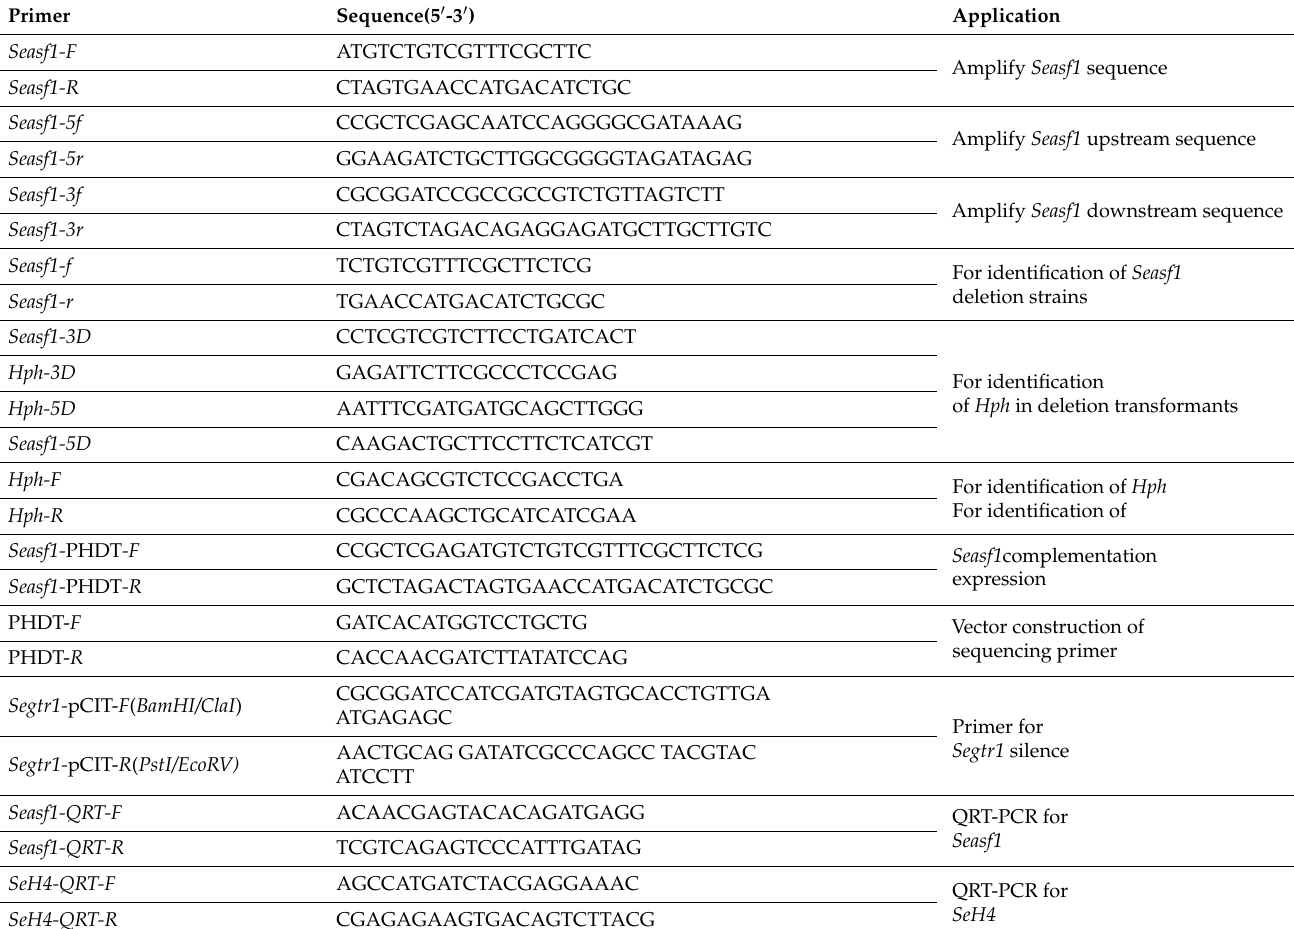
Table 1. Primers used in this